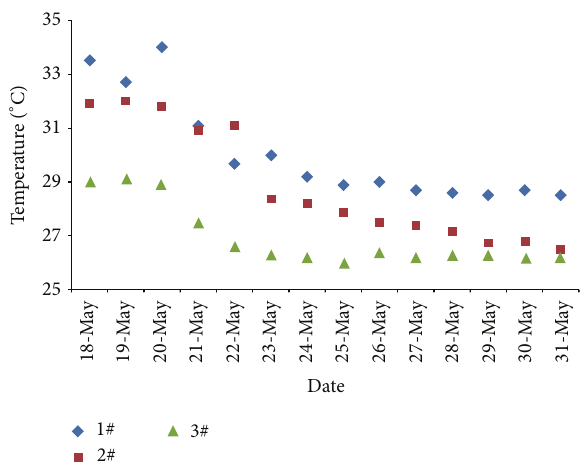
Figure7:COconcentrationofmonitoringsitesafterliquidnitrogen